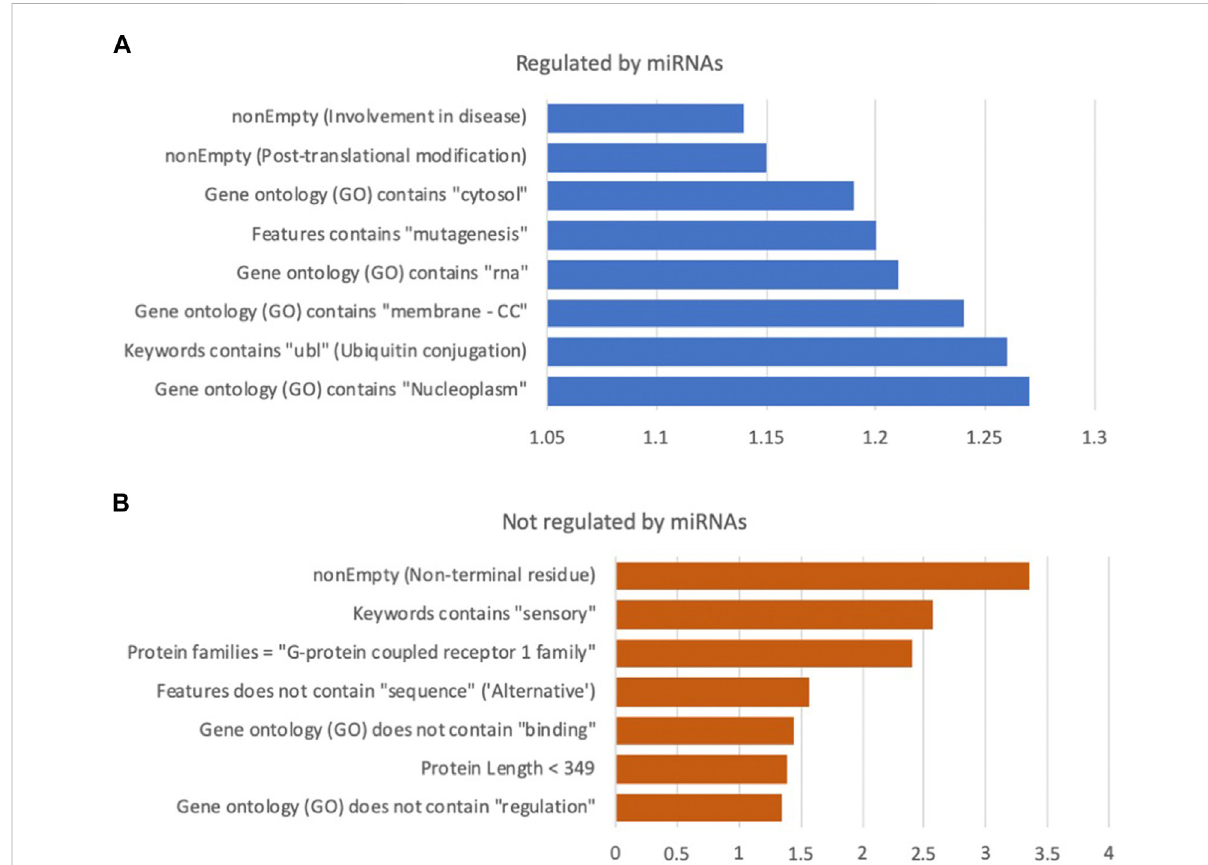
FIGURE 2 Selectionofimpactfulfeaturesfromthehumanproteinmodel. (A) miRNAregulated, (B) notregulatedbymiRNA.The x -axisistheliftofselected features relative to theclass prior baseline (76% regulated,24% not regulated). All above features have an uncorrected p -valueatleastunder 0.0001, using a Chi2 test on the test data. Full list of features and statistics in Supplementary Table S3, along with ranking by information gain (RIG). Note the different scale of the effect in (A,B) . CC: Cellular component branch of GO